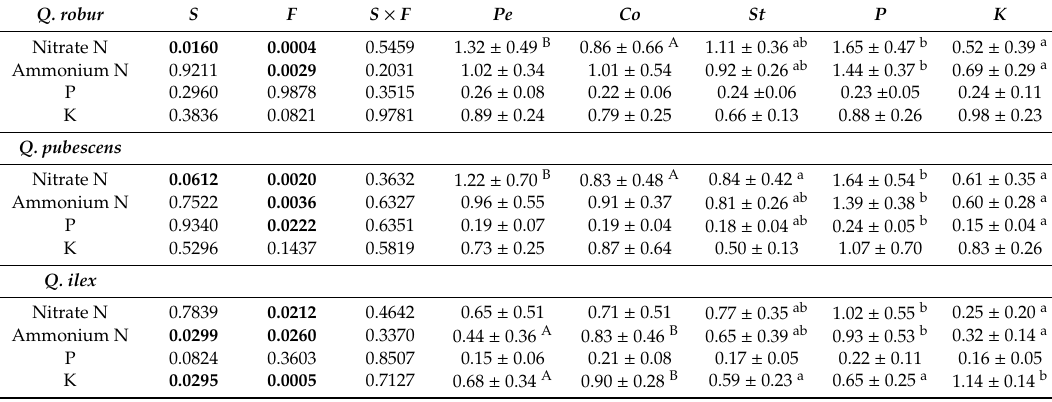
Table 5. Multifactorial ANOVA and Tukey post-hoc test results ( p ≤ 0.05 in bold) for (mean ± SD, N = 6) macro-element concentration (N, P, K) in meq / L contained in the growing media at the end of the season ( N = 12 per combination). Source of variation substrate ( S ), fertilization ( F ), and their interaction ( S × F ). Capital and lowercase letters indicate homogenous groups for S and F , respectively. Pe = Peat; Co = Coir; St = Standard fertilization; K = K-enriched fertilization; and P = P-enriched